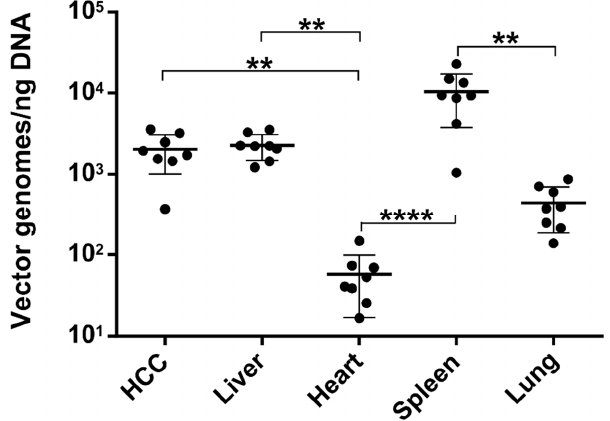
Figure 1. Biodistribution of AAV2 vector in the TGFα/c-myc HCC mouse model. Tumor-bearing animals injected intravenously with scAAV2.SFFV.Fluc and scAAV2.CMV.eGFP. Vector dose: 2 × 10 11 particles per vector per animal. Relative vector genomes were quantified by qPCR 96 h after the first vector (scAAV2.SFFV.Fluc) administration. The levels of firefly luciferase transgene were normalized to ng DNA. Data are shown in log 10 -scale and as the mean target-to-reference ratio per animal with mean and SD. Statistics: Cohort sizes account for Shapiro–Wilk normality test ( p ≤ 0.0459). Shapiro–Wilk normality test with log 10 -transformed data ( p = 0.0209); Kruskal–Wallis test ( p < 0.0001) and Dunn’s test ** p < 0.01, **** p < 0.0001). N = 8 animals.